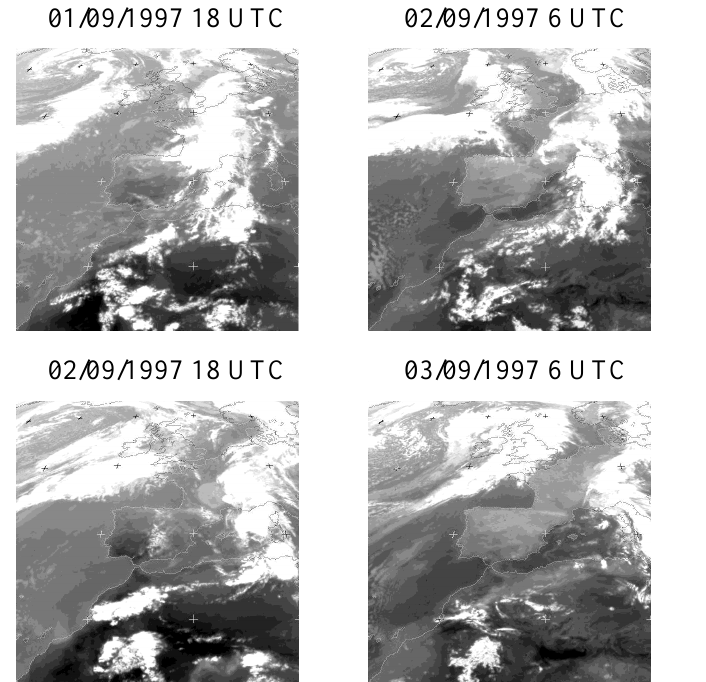
Fig. 13. Meteosat infrared images of western